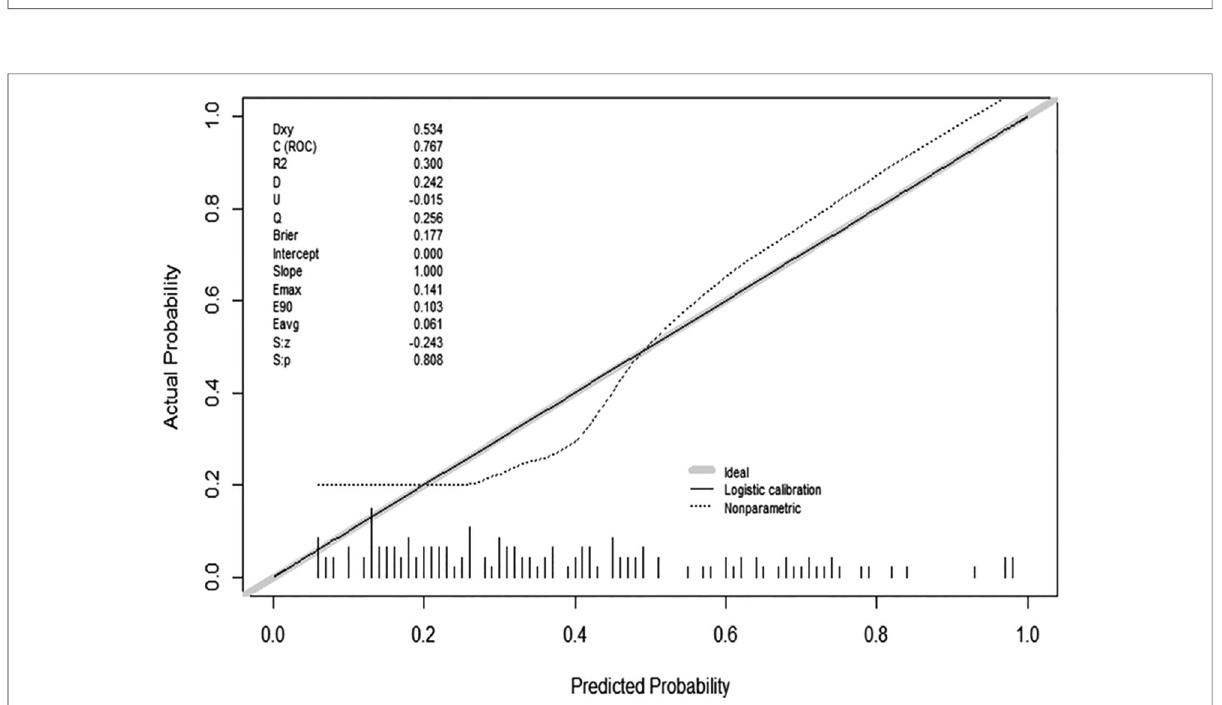
FIGURE 2 Nomogram for predicting the CPSP risk and its algorithm. First, a point was found for each variable of a lung adenocarcinoma patient after surgery under VATS on the uppermost rule. Then, all scores were added together, and the total number of points was collected. Finally, the corresponding predicted probability of CPSP was found on the lowest